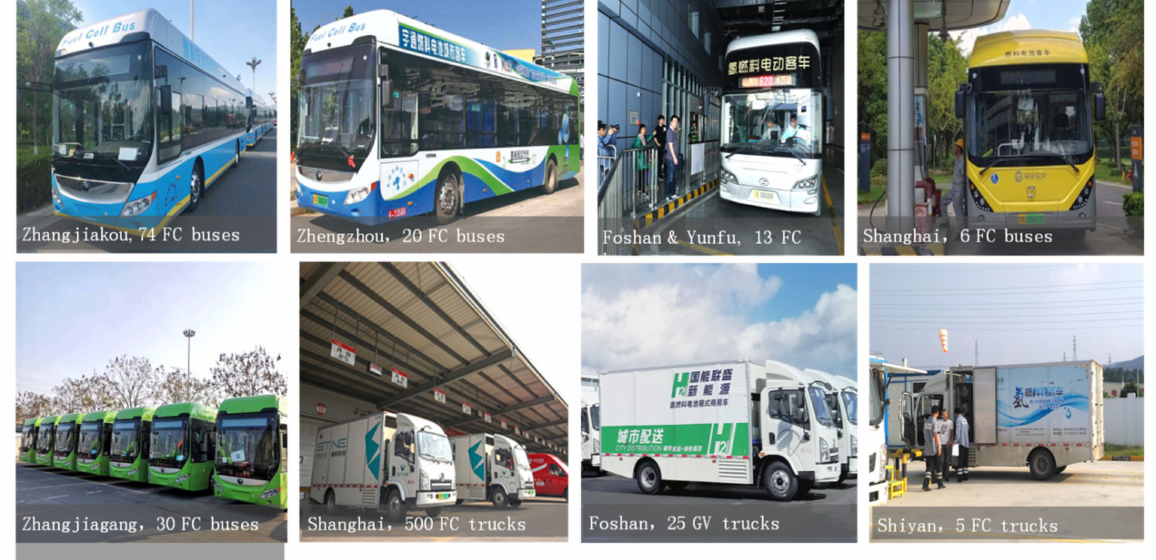
Figure 5. The use of fuel cell electric vehicles is progressing in many cities across China.